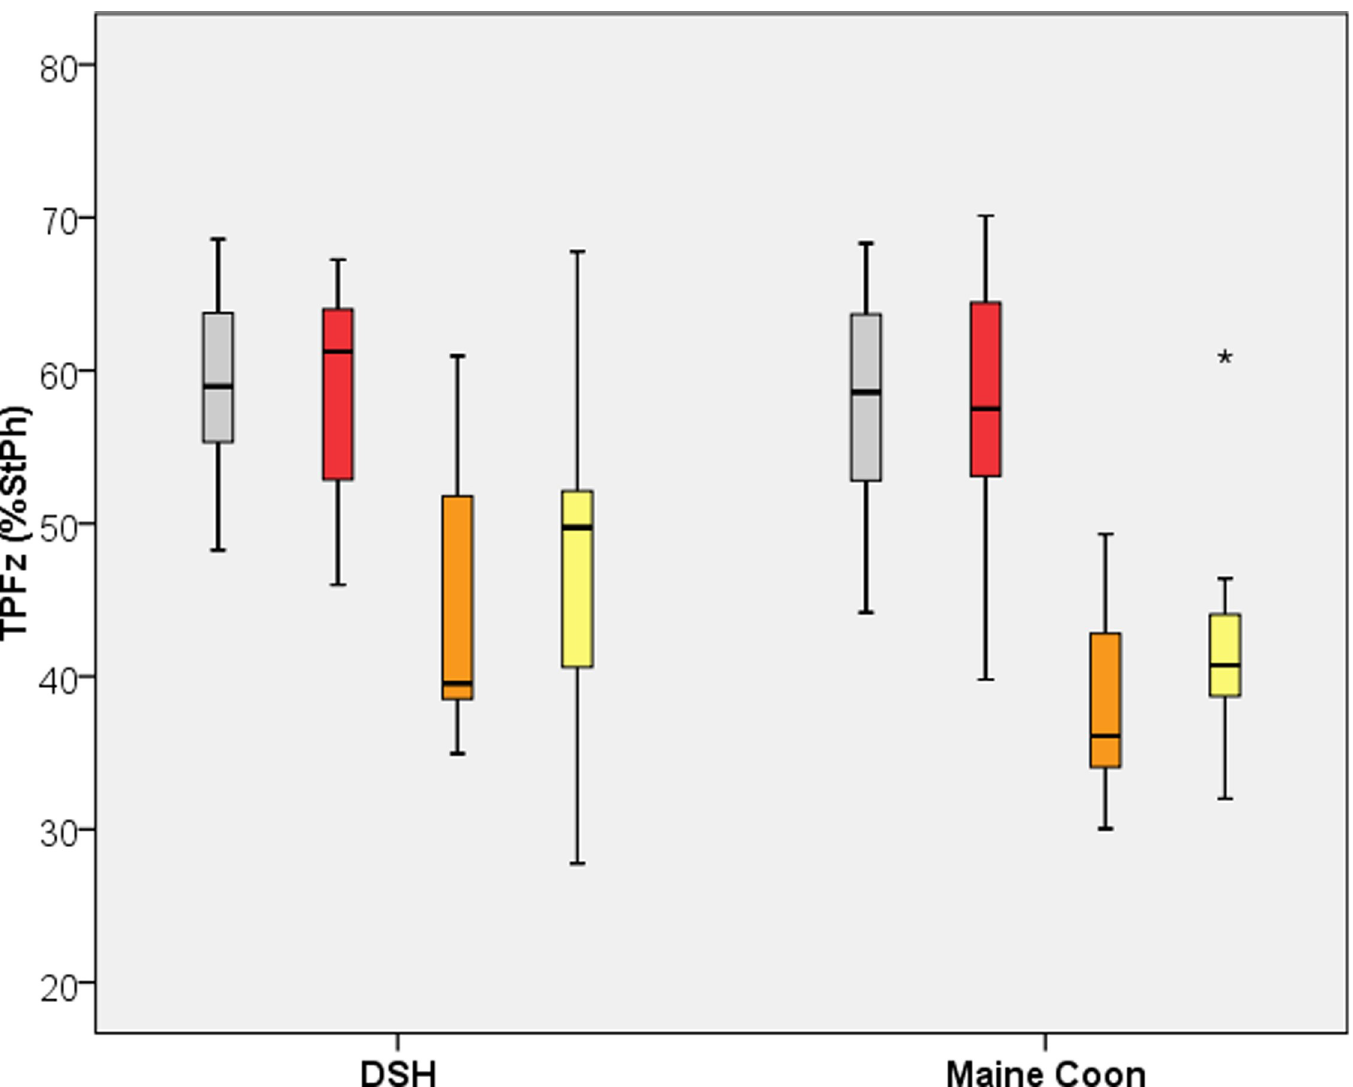
Fig 4. Boxplot of the Time to PFz (TPFZ) for Domestic Shorthair and Maine Coon Cats. Grey = left forelimb, red = right forelimb, orange = left hind limb, yellow = right hind